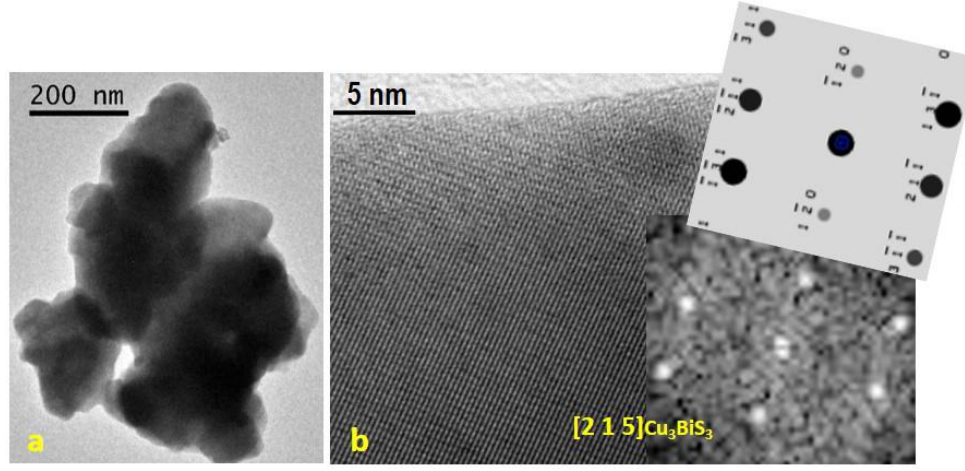
Figure 3. ( a ) TEM and ( b ) HRTEM images of mechanochemically synthesized Cu 3 BiS 3 . The corre- sponding FFT and calculated EDP are